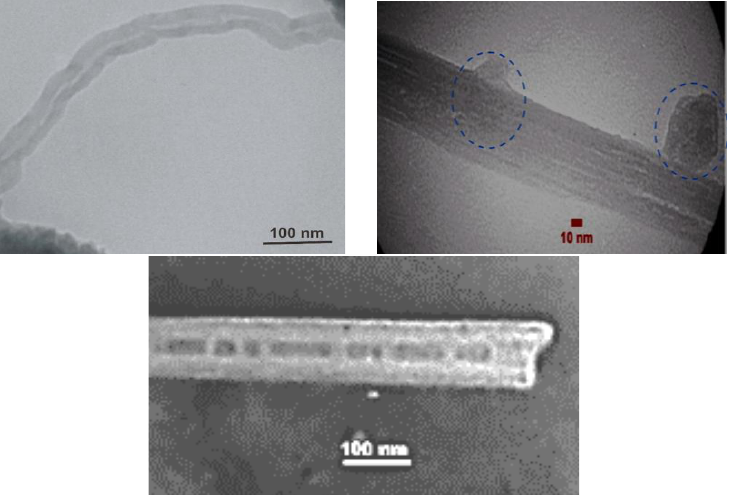
Fig. 7. TEM microscopy results of three types of DNTs; Top (left), simple DNTs; Top (right) 29 , DNTs carrying MNPs on the surface 29 ; Bottom, MNPs-encapsulated DNTs.